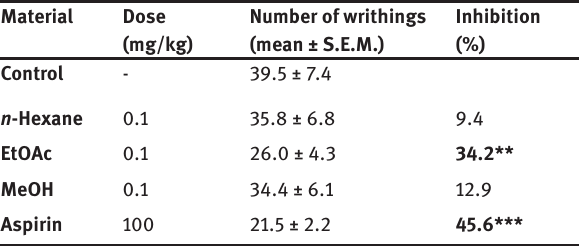
Table 3: Effects of the extracts against p -benzoquinone-induced writhings in